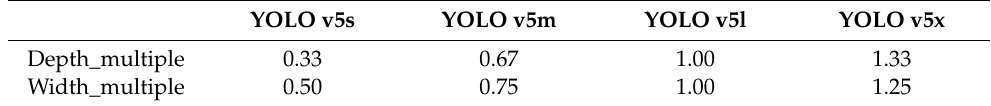
Table 2. YOLO v5 network specifications by